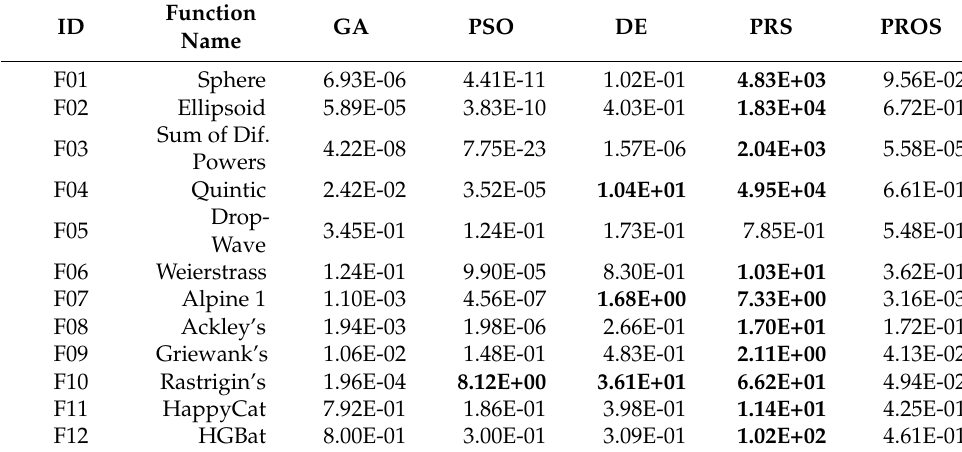
Table 6. Best results * for all 5 optimizers and all 12 objective functions, for 10 dimensions ( D = 10, averages of 10 runs). The target (optimum) value is zero in all cases considered.